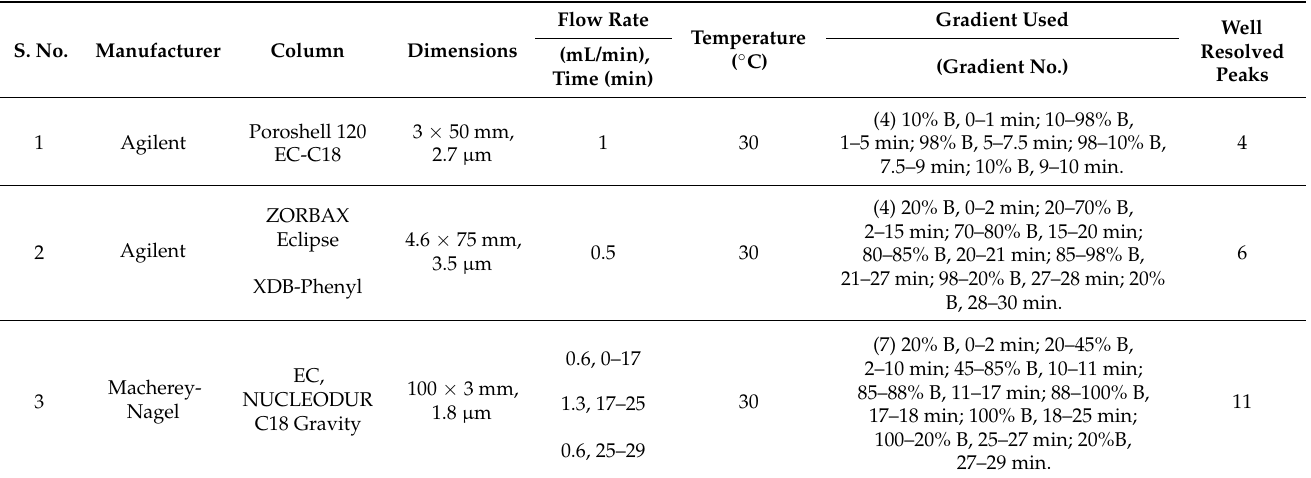
Table 1. Stationary phase optimization.